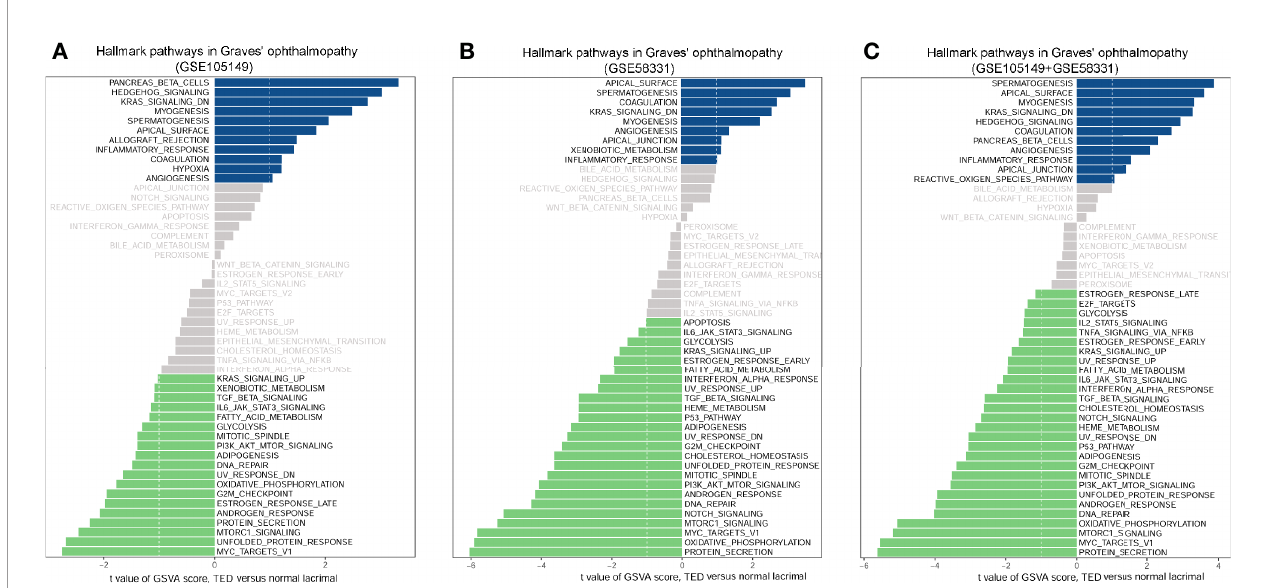
FIGURE 6 | Scores of gene set variation analysis (GSVA) for pathway activities between thyroid eye disease (TED) and normal lacrimal gland. (A) GSVA analysis of four TED versus seven normal lacrimal samples of GSE105149. (B) GSVA analysis of seven TED versus seven normal lacrimal samples of GSE58331. (C) The common GSVA analysis of 11 TED versus 14 normal lacrimal samples of GSE105149 and GSE58331. Shown are t values from a linear model, corrected for patient of origin. DN, down; v1,